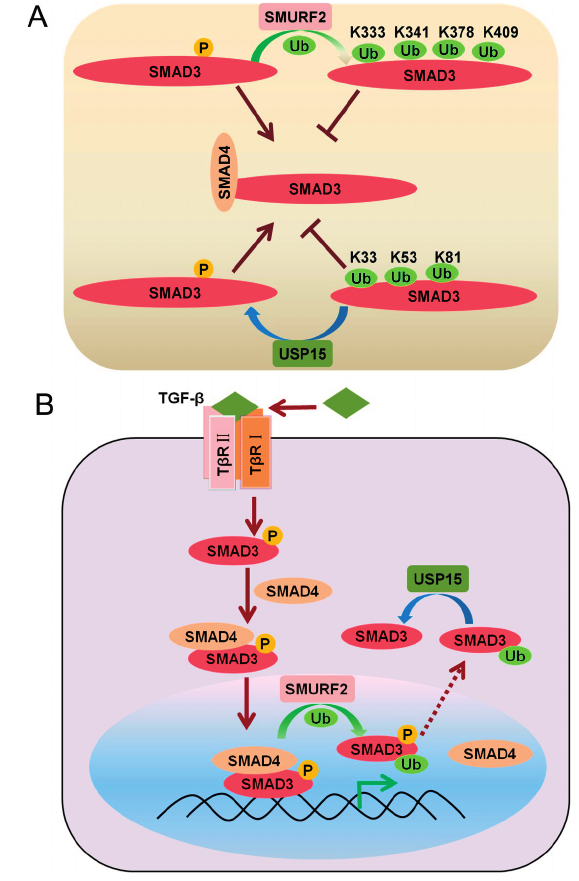
Figure 3. ( A ) SMURF2 and USP15 control the mono-ubiquitination state of SMAD3 ( B